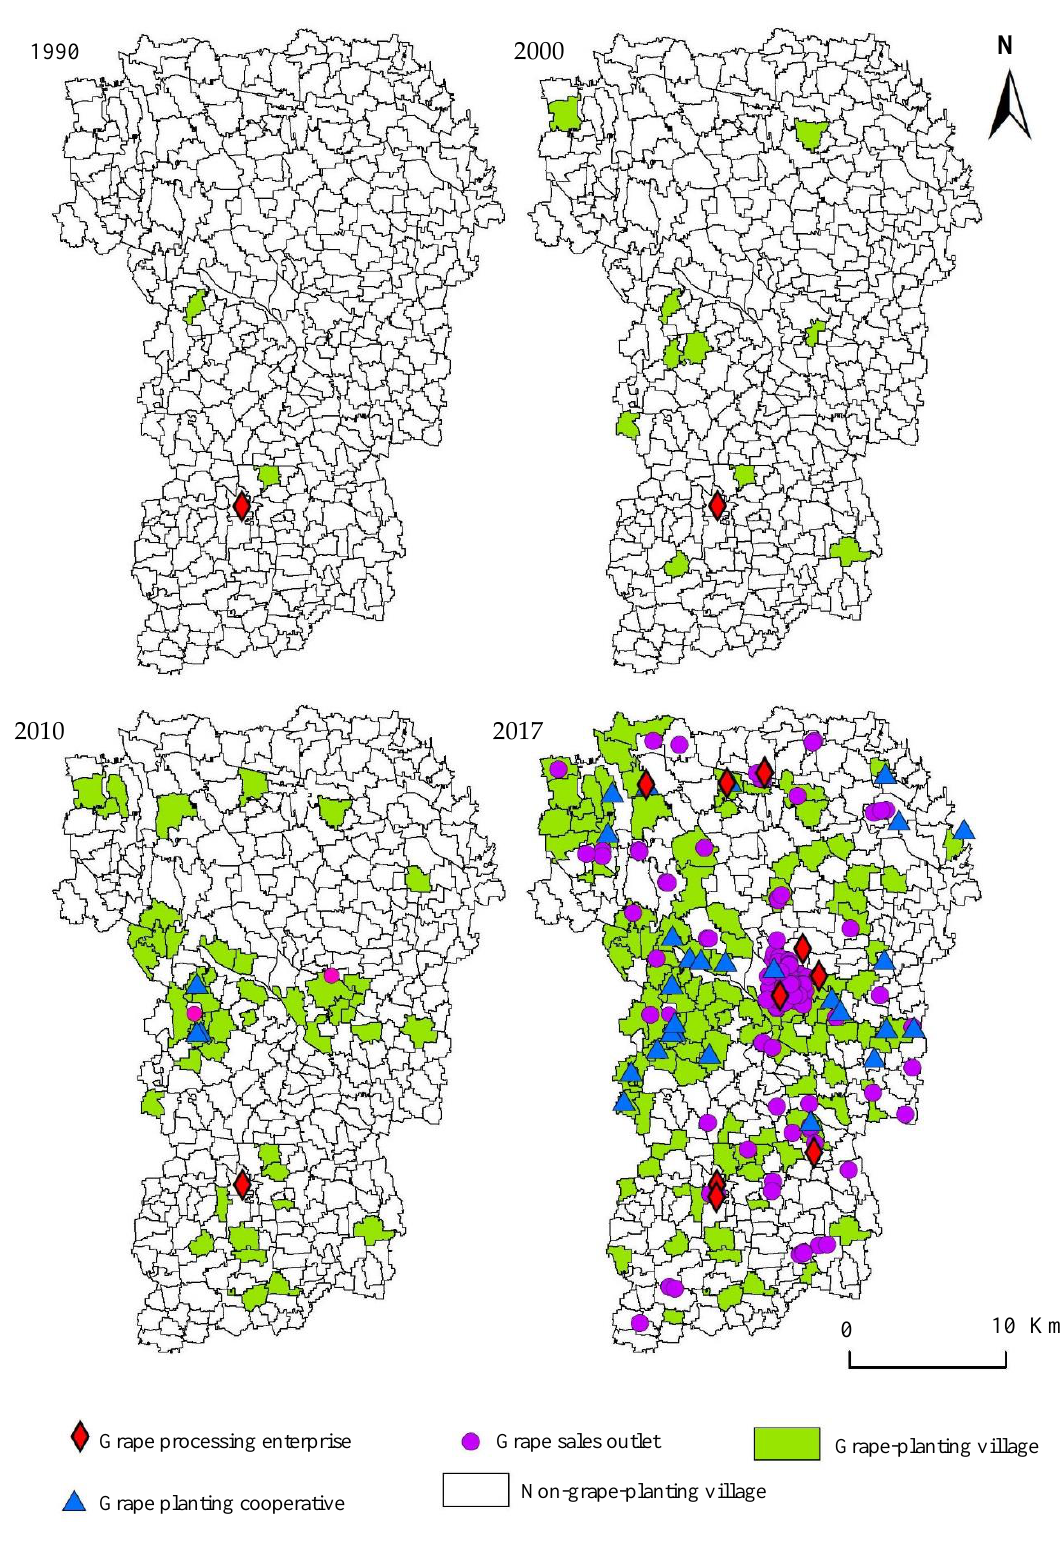
Figure 7. Locations of different producers.